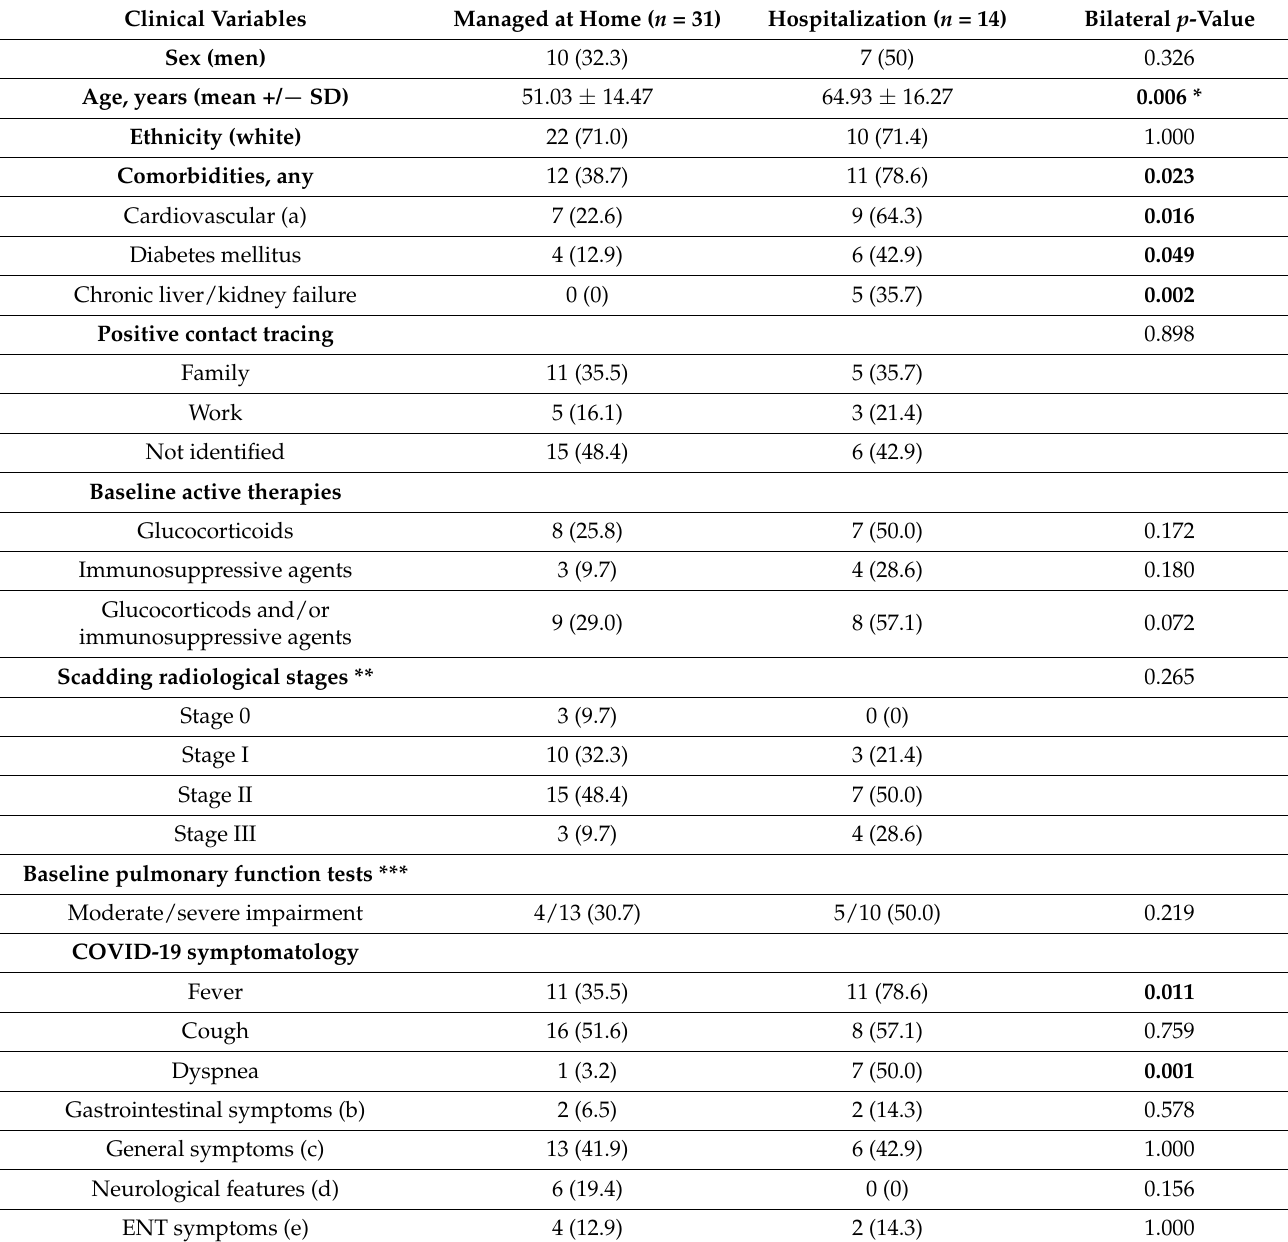
Table 2. Demographic, clinical, radiological and laboratory features stratified by SARS-CoV-2 infection severity defined as requirement or not of hospital